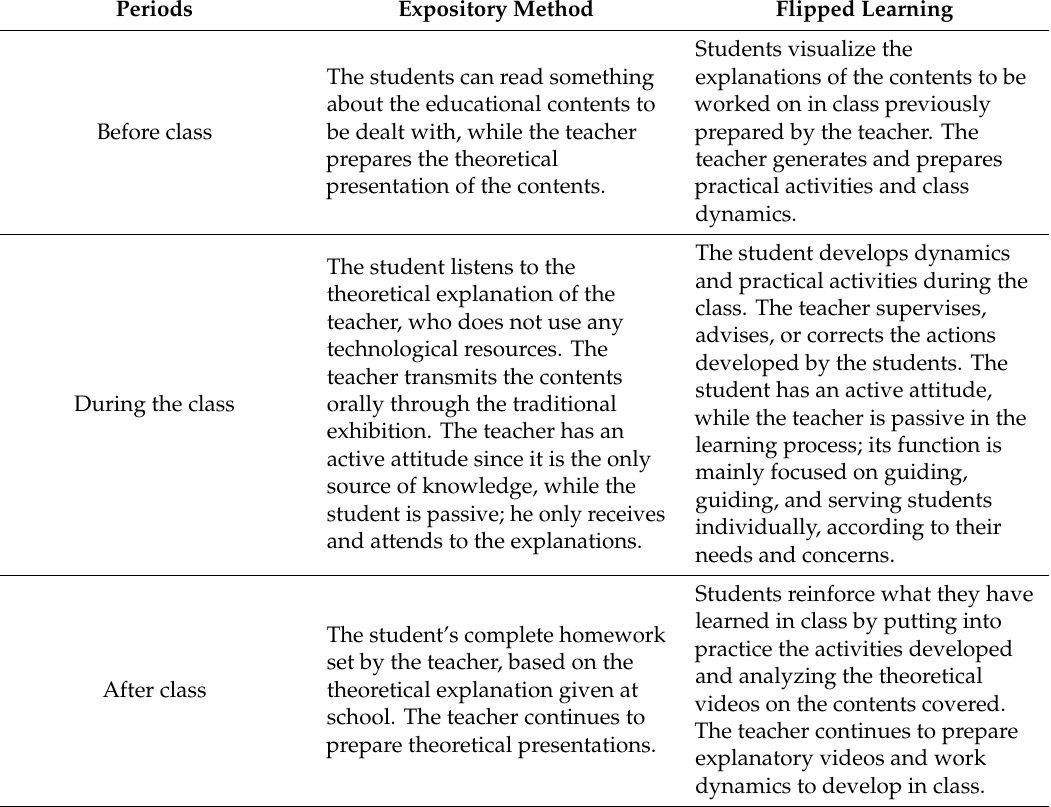
Table 1. Comparison between expository method and flipped learning